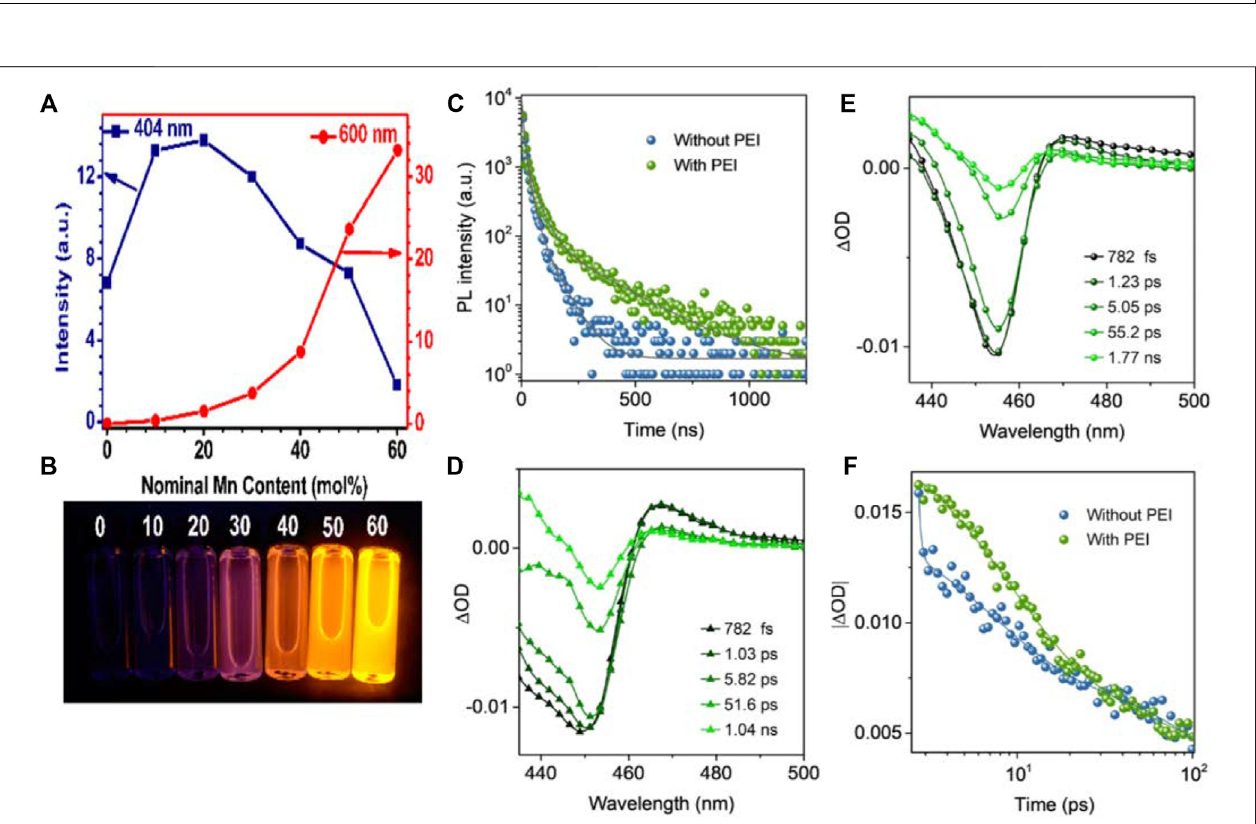
FIGURE3|(A) PLspectraand (B) LuminescencephotosofdifferentMn-dopedratiosunderUV(Zouetal.,2017). (C) PLdecayofCsPbBr 3 QDs; (D,E) TAspectra of CsPbBr 3 QDs with and without PEI; (F) Comparisons of TA bleach recovery kinetics (Yin et al., 2021).